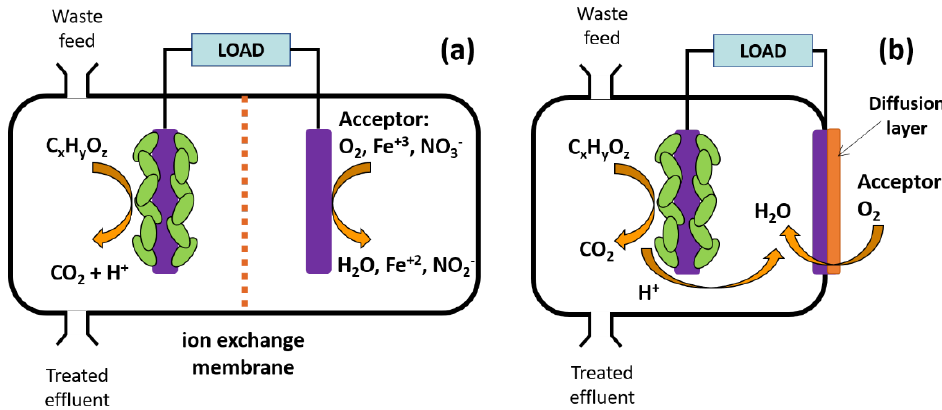
Figure 1. Schematic of a microbial fuel cell in the ( a ) double-chamber and ( b ) single-chamber configurations for the oxidative treatment of organic compounds from waste coupled to power generation through an external circuit. Electrocatalysis at the anode takes place thanks to the formation of an electroactive biofilm that can transfer electrons to the electrode serving as a current collector.